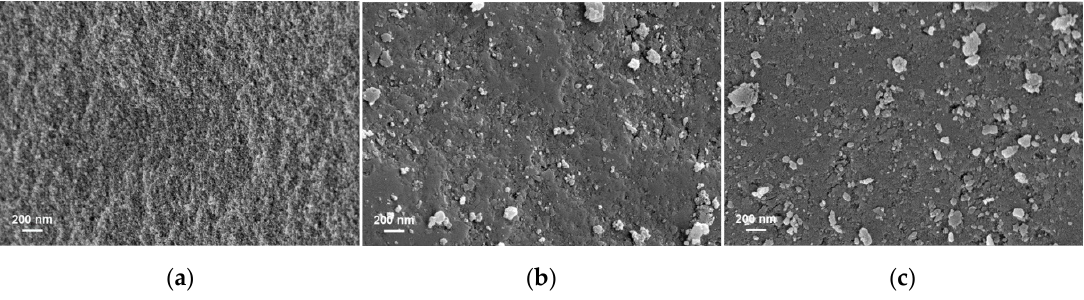
Figure 7. Scanning electron micrographs of: ( a ) as-made silica, ( b ) (3-Aminopropyl)triethoxysilane (APTES)/ethanol impregnating solution 20/80 (APTES20) and ( c ) 40/60 (APTES40).